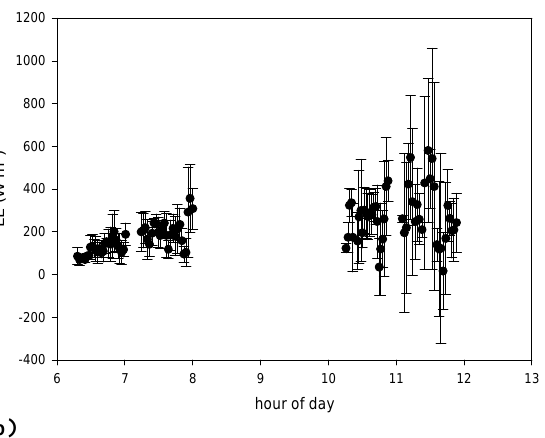
Table 6. Averaged CO 2 fluxes (µmolm − 2 s − 1 ) along the flightpath for both flights on 16 July 2002. As in Table